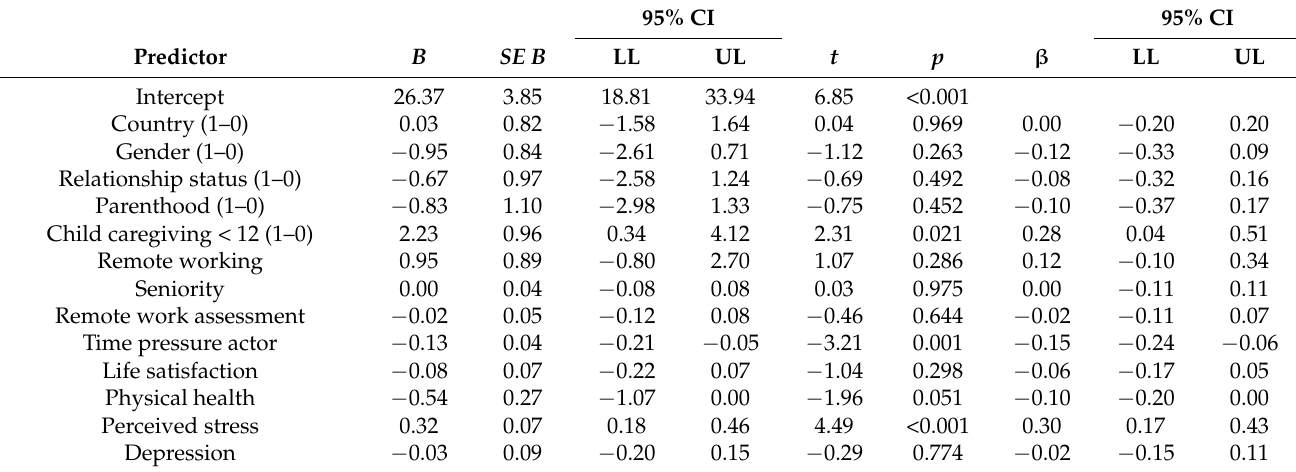
Table 3. Multiple linear regression for family-work